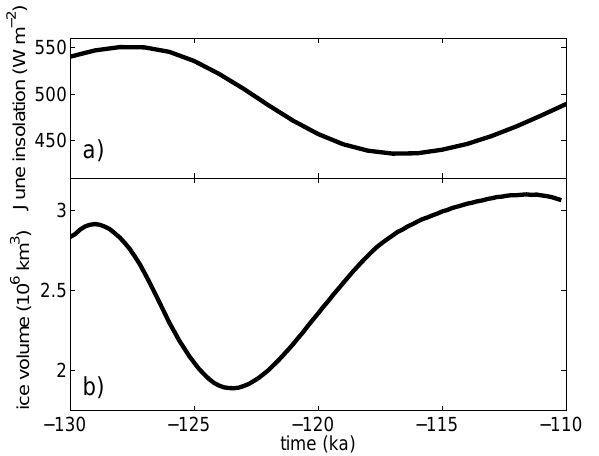
Fig. 7. Anomalies and ratios of change at the first model time step, thus independent from changes in ice topography and dynamics: Left: melt anomaly ‘126 ka - 0 ka’ (color, m/yr) and initial ice elevation (contours, m). Right: accumulation anomaly ‘126 ka - 0 ka’ (color, m/yr). With 126 ka climate boundary conditions, melting increases throughout the entire ice sheet, mostly in low-lying regions and in large regions in northern Greenland. Accumulation changes are at least one order of magnitude smaller.